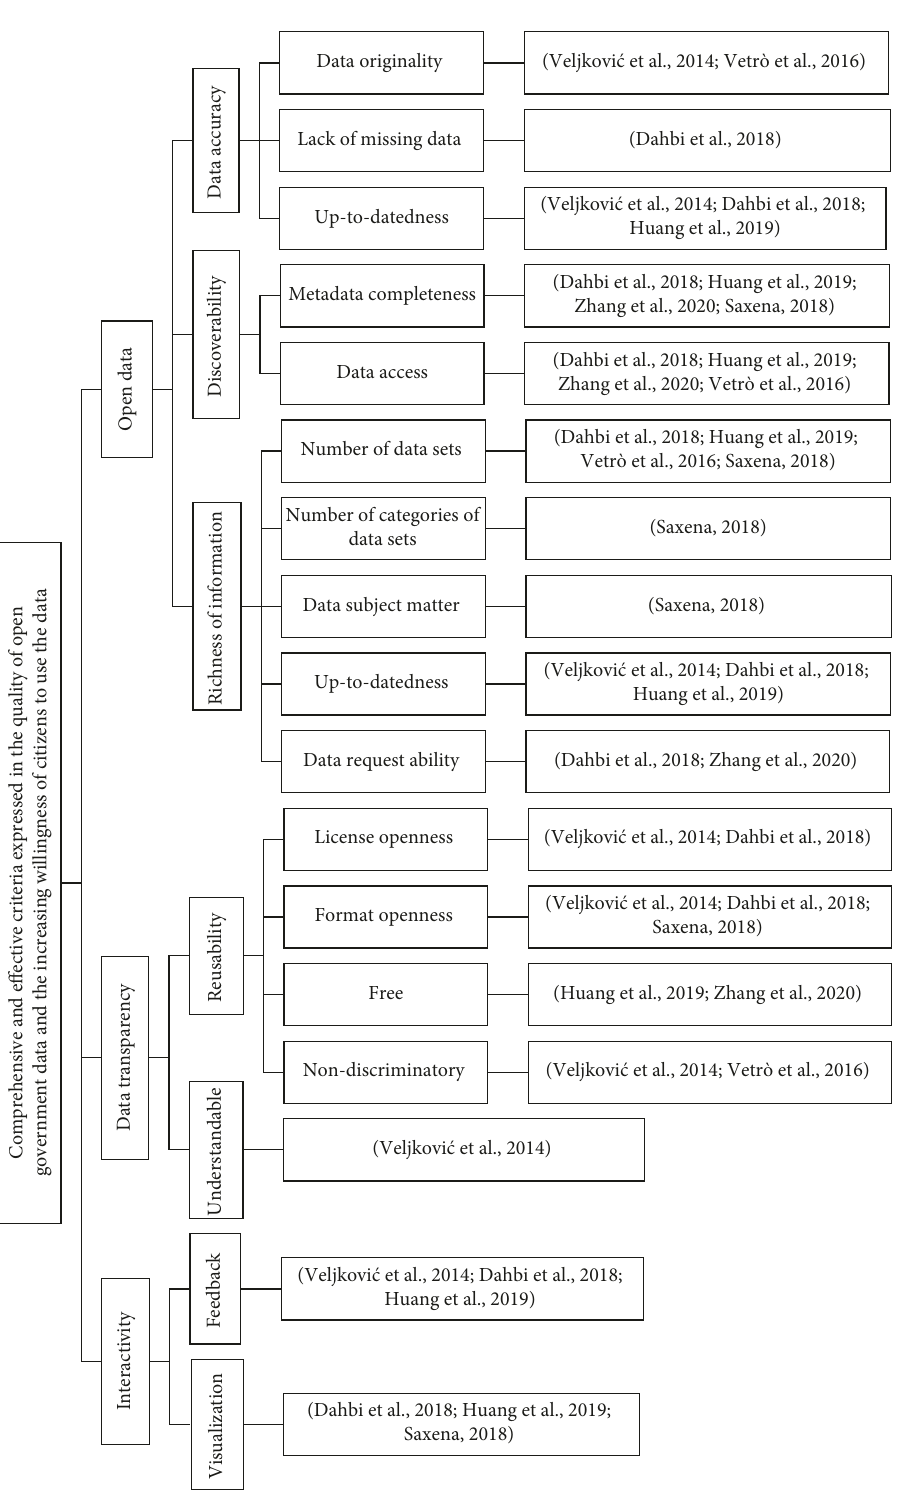
Figure 3: Chart of effective criteria in the quality of open government data and increasing the willingness of citizens to use data based on dimension, criteria, reference, and year of